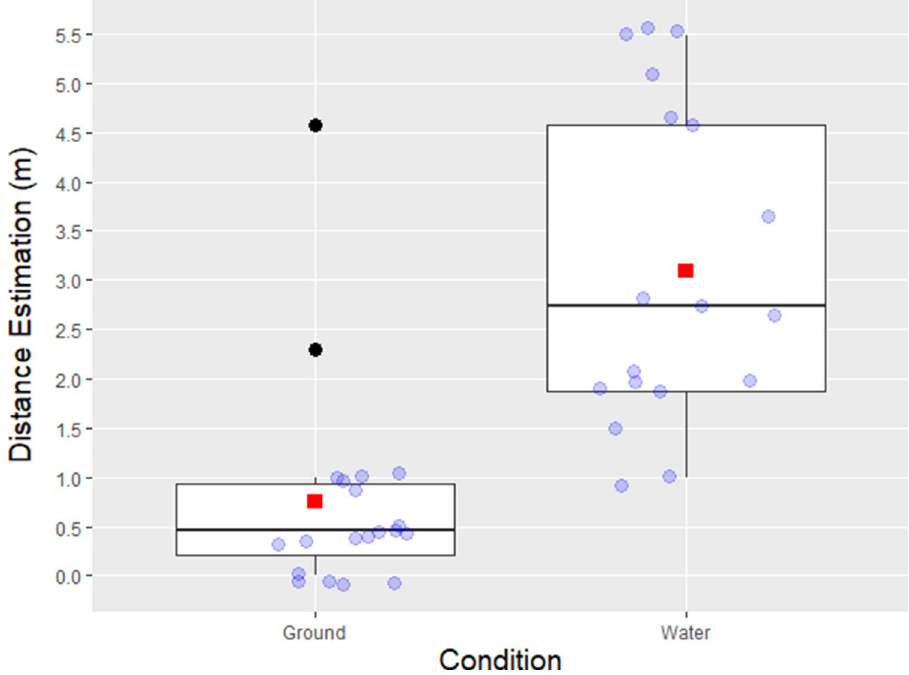
Figure 1. Comparison of the distance estimation in meters between Ground and Water conditions. Boxplot presenting medians, interquartile ranges, minimum and maximum and potential outliers. The boxplot identified the means (red squares) for each condition and two outliers (black dots) in the Ground